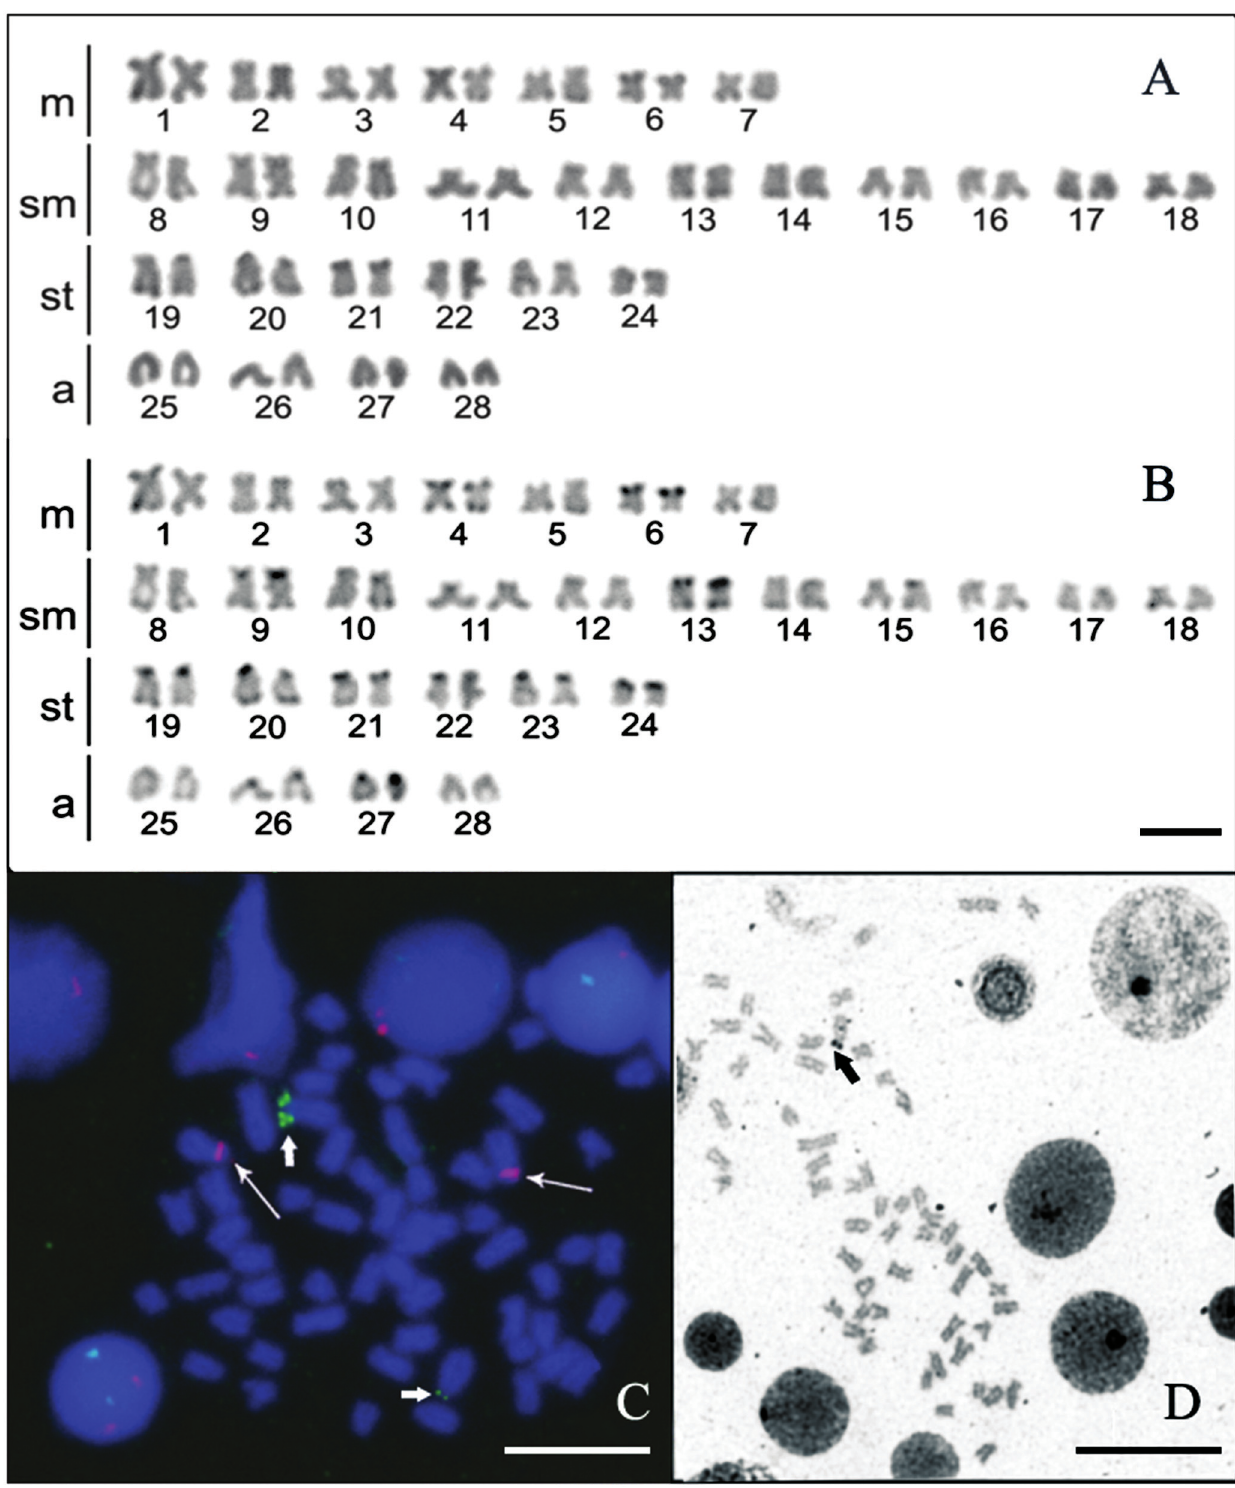
Fig. 4. Karyotype in Giemsa ( A ), C band ( B ), FISH with 18S probe (green arrows) and 5S probe (pink arrow) ( C ) and Ag-NORs ( D ) in Steindachneridion parahybae from the rio Paraíba do Sul (SP). m = metacentric; sm = submetacentric; st = subtelocentric; a = acrocentric. Scale bars = 10 μ